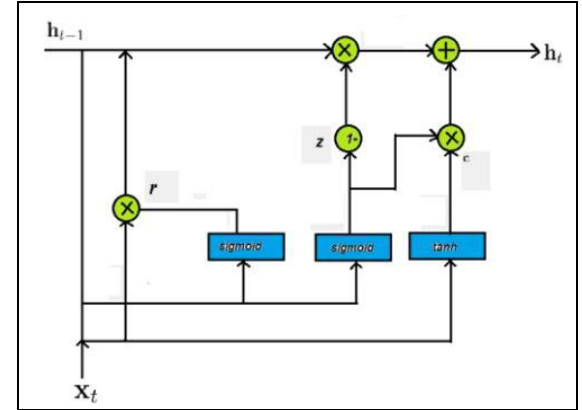
Fig.6. Internal architecture of GRU cell[12] DeepAR is a forecasting method based on